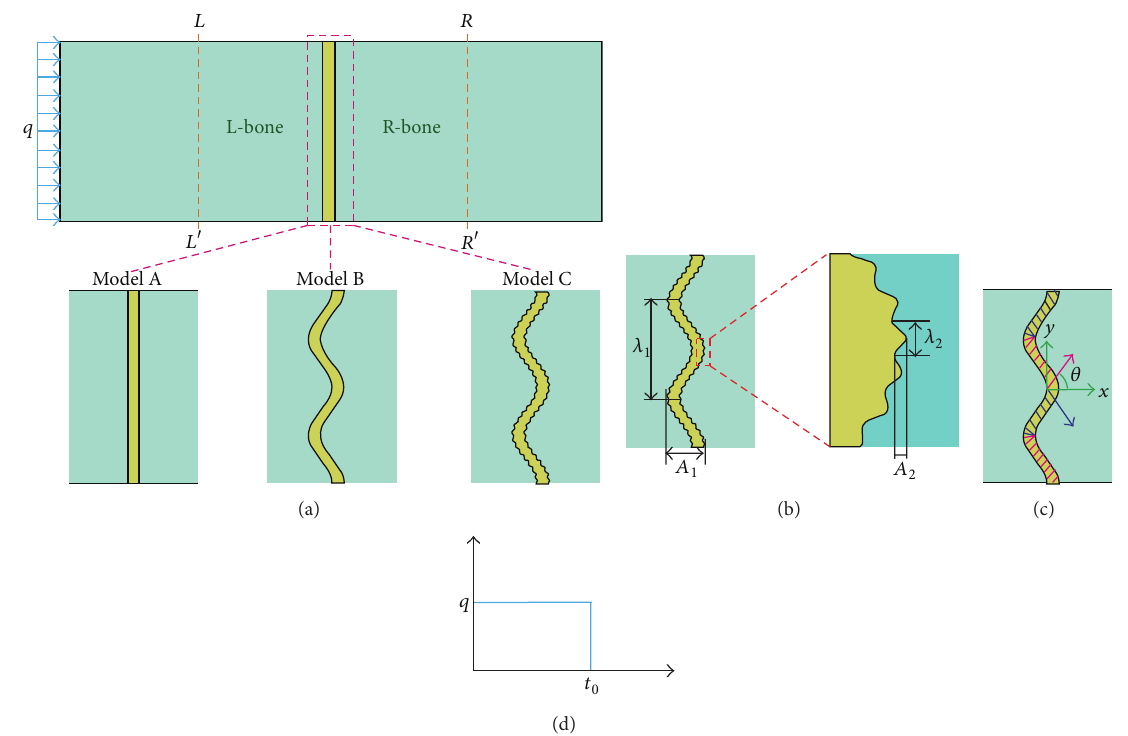
Figure 1: (a) Three different bone-suture models: model A with straight suture, model B with first-order sinusoidal suture, and model C with hierarchical sinusoidal suture. (b) Geometric parameters of model C. (c) Fiber arrangement inside the suture. (d) History of impulsive loading applied on the left side of the bone-suture